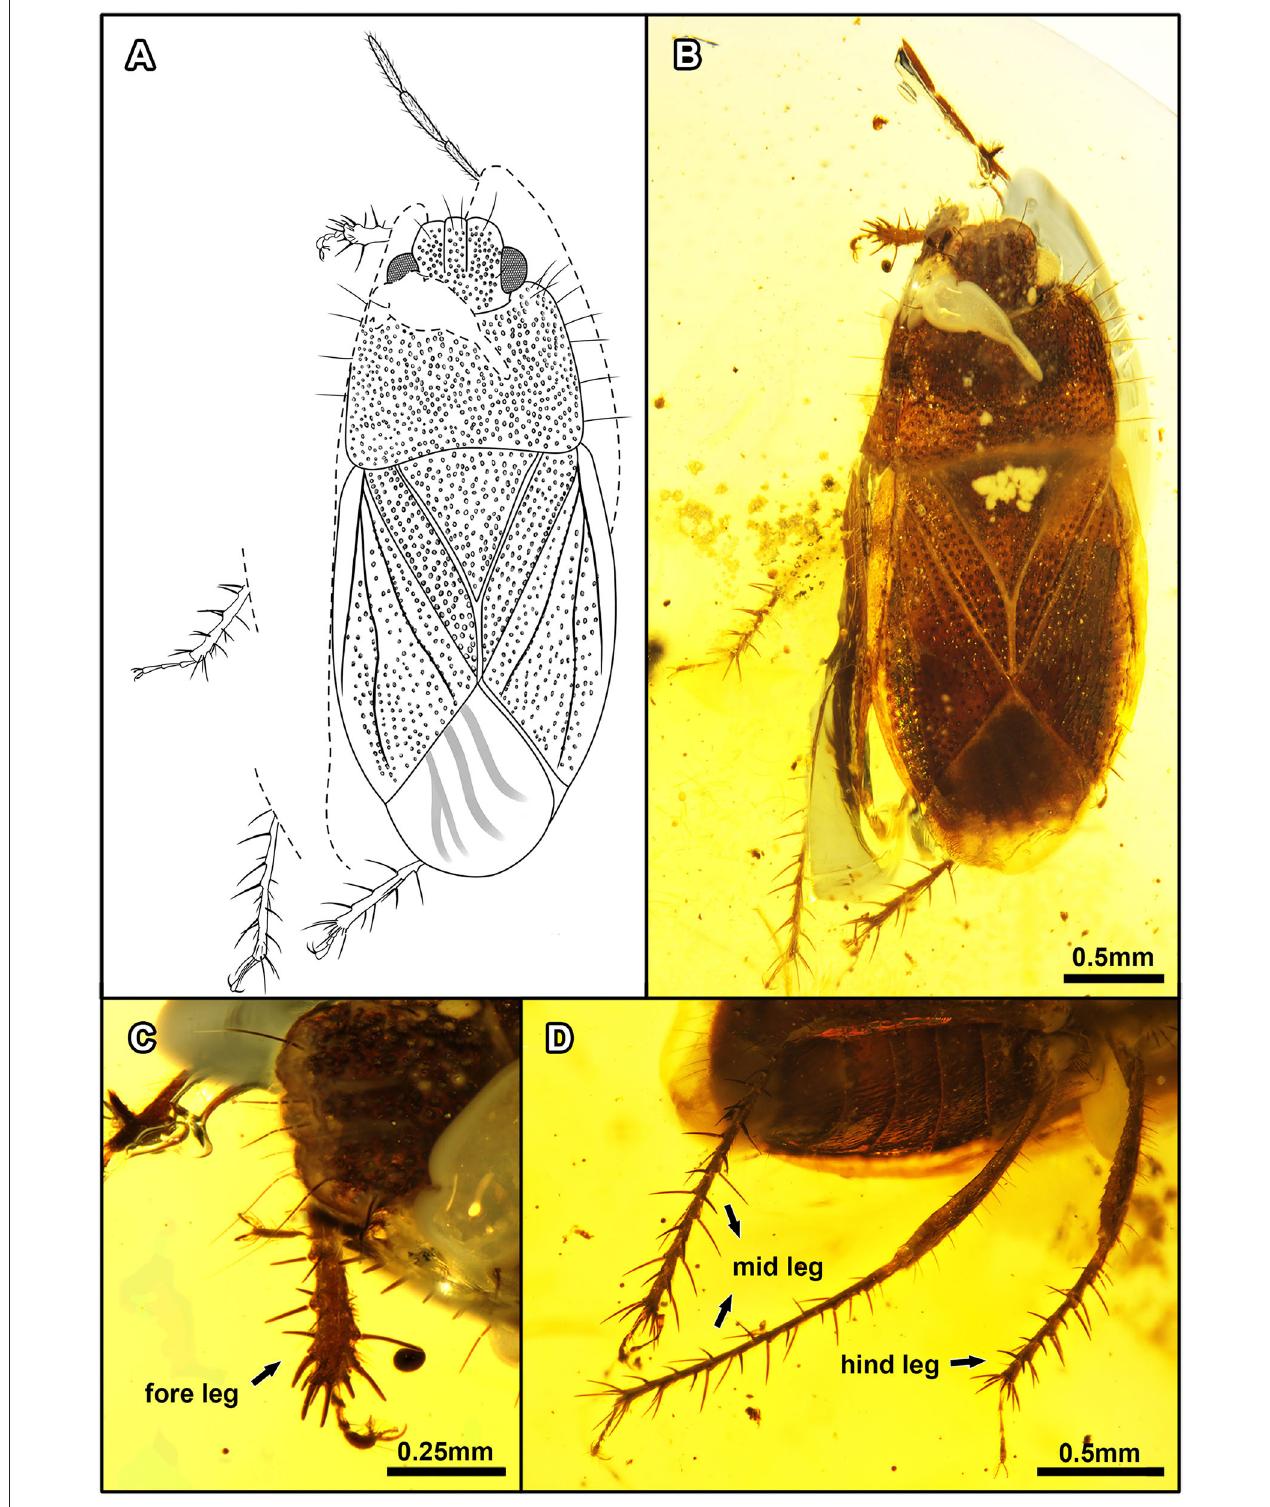
FIGURE 7 | Quinalveus hui gen. et sp. nov., in Burmese amber. Holotype, CNU-HET-MA2019005 (male). (A) Line drawing in dorsal view. (B) Habitus in dorsal view. (C) Protibia. (D) Meso- and metatibiae. Scale bars: A = B = 0.5mm; C = 0.25mm; D = 0.5mm.